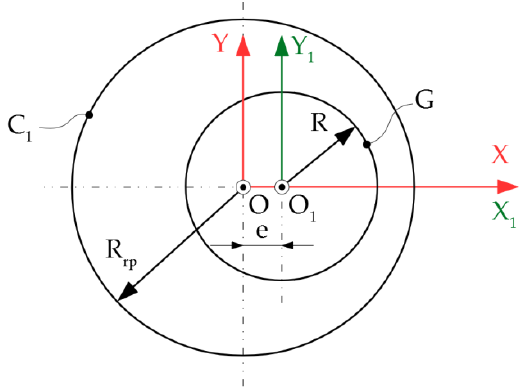
Figure 3. Reference systems used for active surface determination.